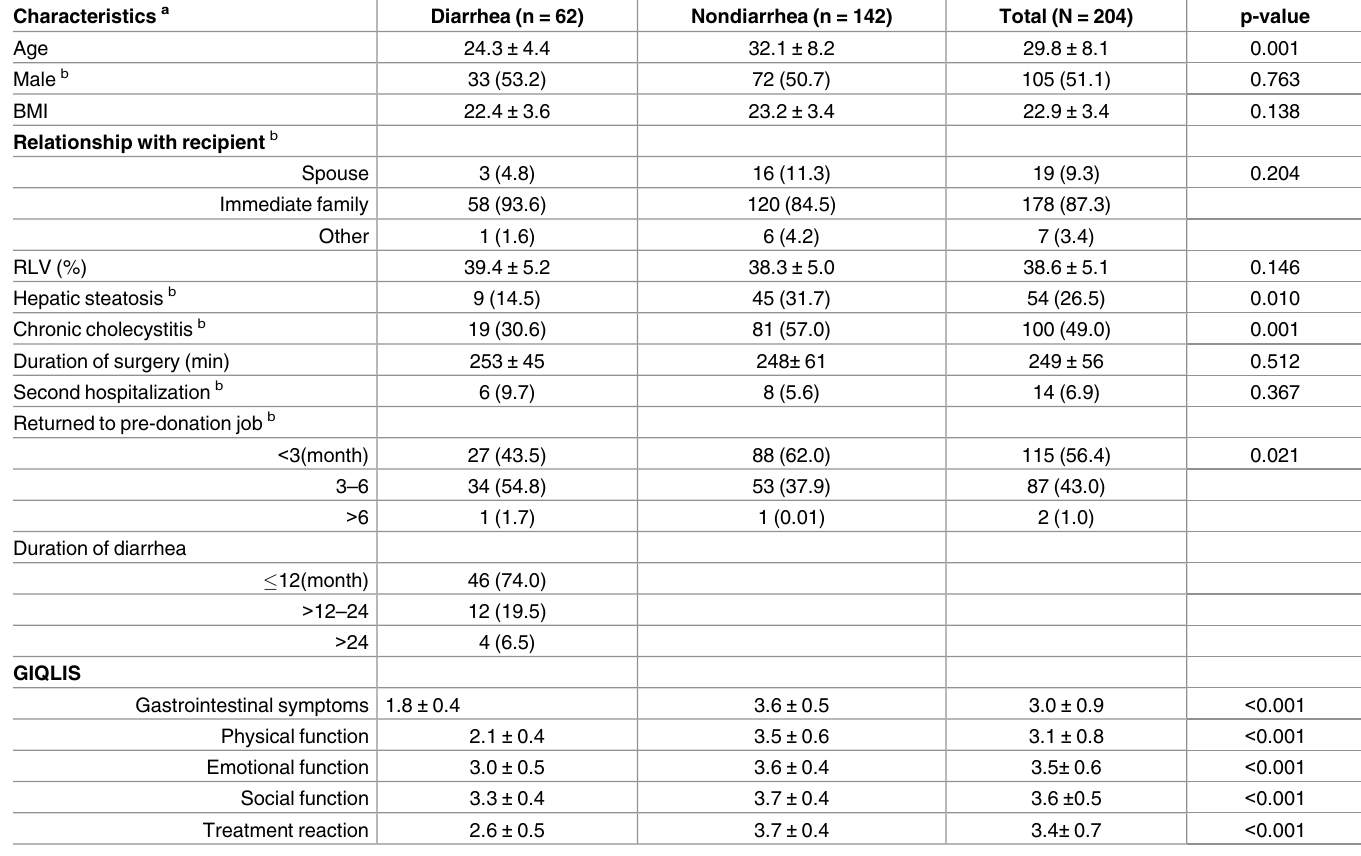
a Data are shown as mean ± standard deviation and compared using the Mann-Whitney test. b Data are shown as n (%) and compared using the chi-square test.